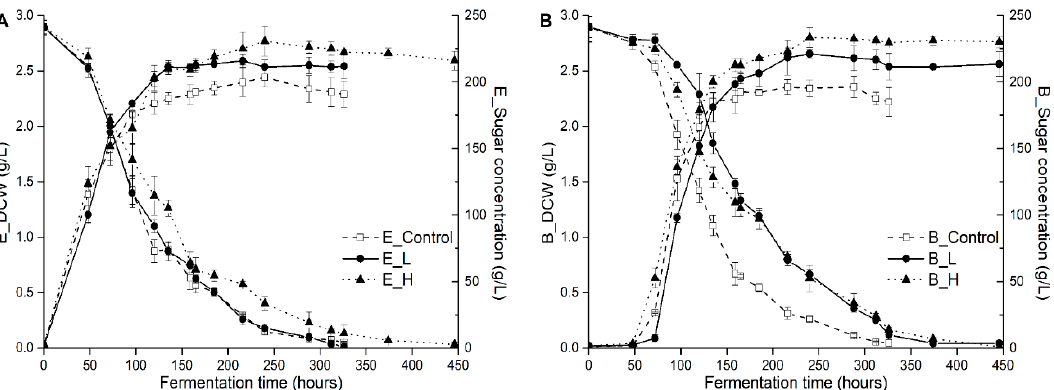
Figure 1. Cell growth and sugar consumption of EC1118 ( A ) and BDX ( B ) treated by different levels of UFAs during alcoholic fermentation (Control, L, and H represented the control, low-UFAs, and high-UFAs added juice).